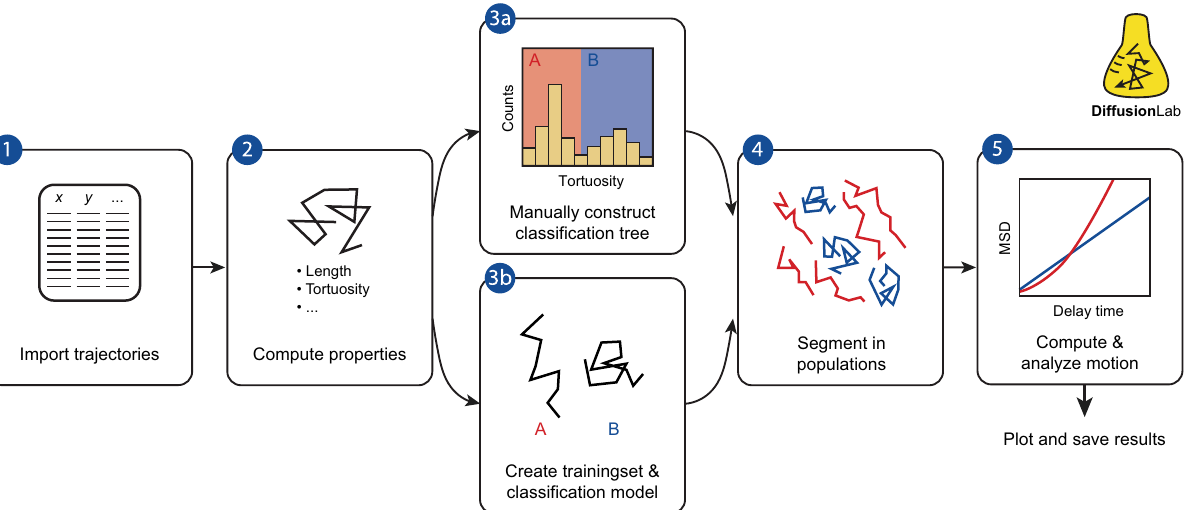
Figure 1. Workflow of population-based motion analysis in DiffusionLab: (1) the trajectories are imported; (2) a set of descriptors (properties) of each trajectory is computed; (3) a classification model is constructed, this can either be done manually as a hierarchical classification tree (3a) or via supervised machine learning (3b); (4) the classification model is used to classify all trajectories in populations with similar motion behaviour; and (5) the mean squared displacement (MSD) of the populations is analysed separately. Finally, the properties and motion analysis results can be plotted, saved and/or exported.